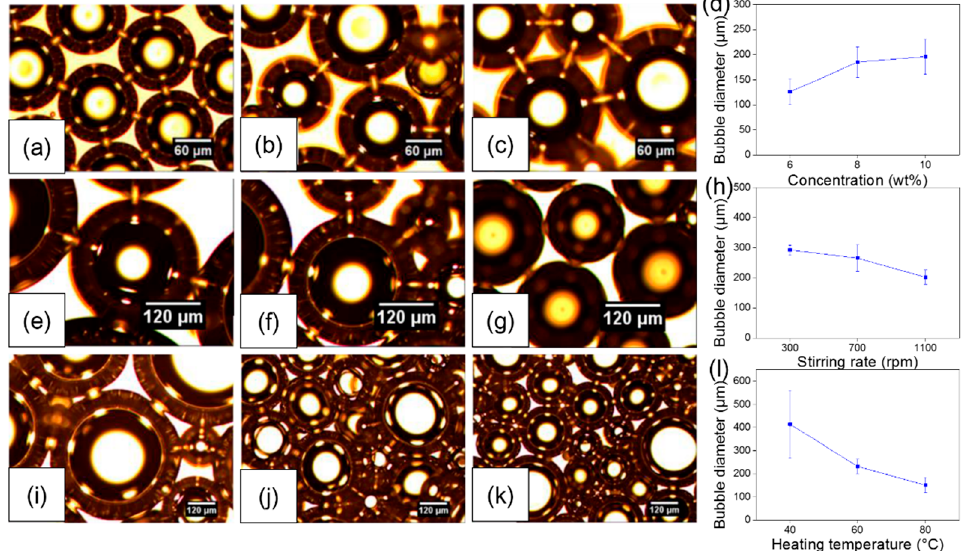
Figure 2. Effect of bubble preparation parameters on their size distribution. Optical micrographs of bubbles prepared using different PVA solution concentrations with all other parameters constant (stirring rate: 700 rpm; heating temperature: 60 °C): ( a ) 6; ( b ) 8; and ( c ) 10 wt %. ( d ) Bubble size distribution as a function of solution concentration. Optical micrographs of bubbles fabricated using various stirring rates with all other parameters constant (solution concentration: 10 wt %; heating temperature 60 °C): ( e ) 300; ( f ) 700; and ( g ) 1100 rpm. ( h ) Bubble size distribution as a function of stirring rate. Optical micrographs of bubbles produced at different heating temperatures with all other parameters constant (solution concentration: 10 wt %; stirring rate: 700 rpm): ( i ) 40; ( j ) 60; and ( k ) 80 °C. ( l ) Bubble size distribution as a function of solution temperature.